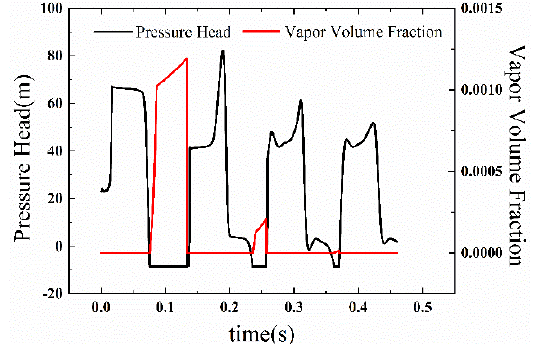
Figure 29. Pressure head change and vapor volume fraction change at S 3 monitoring position (0.02 m upstream of the valve).